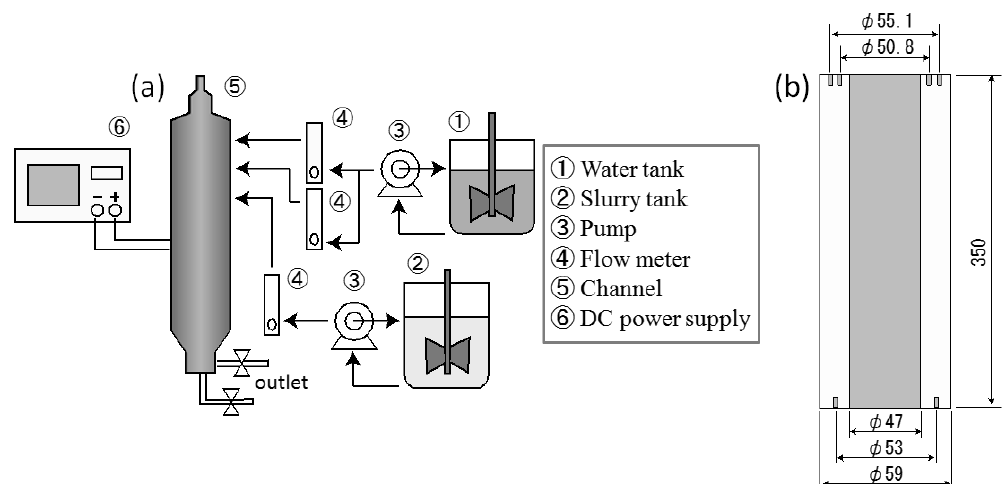
Fig. 2 Experimental apparatus: (a) experimental system; (b) sectional details of the